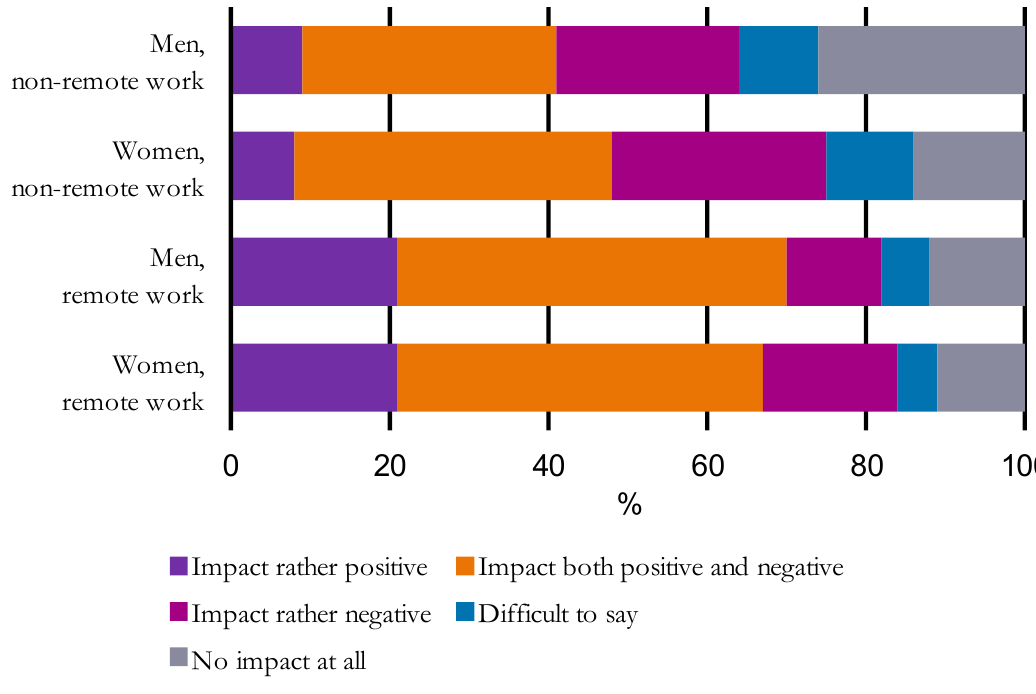
Source: Statistics Finland, Koronakriisin vaikutukset työelämään [ The Impact of the Corona-crisis on Working Life 2021